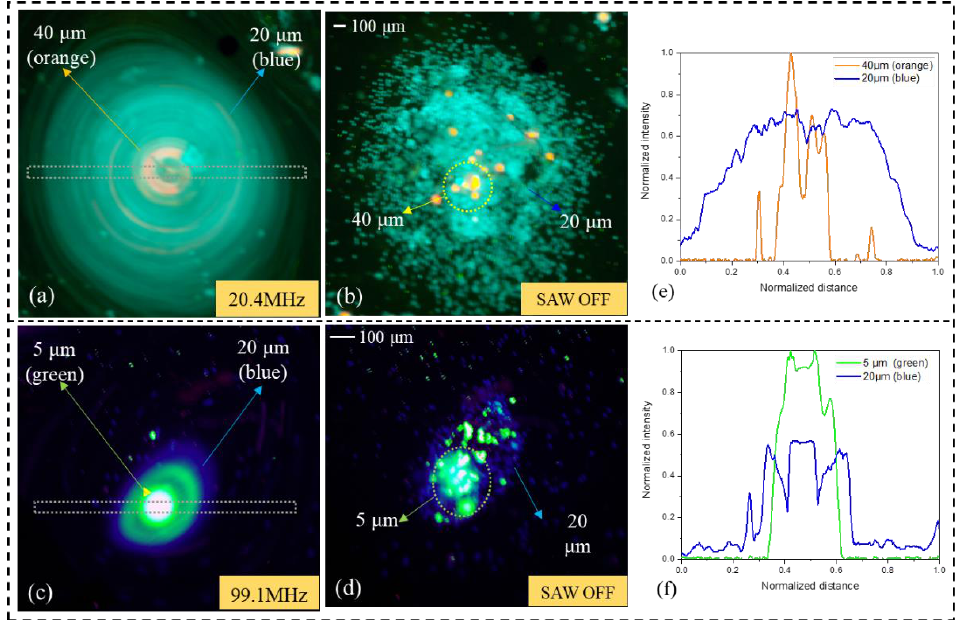
Figure 9. Multilayered particle agglomerates of 20 μm wrapped around 40 μm ( a , b ) and 20 μm wrapped around 5 μm ( c , d ). The normalized fluorescence intensities (NFI) values measured from the vortex centers (see the dashed rectangles in ( a , c ), from left to right) are plotted in ( e , f ) to characterize the distribution of particles of different sizes.